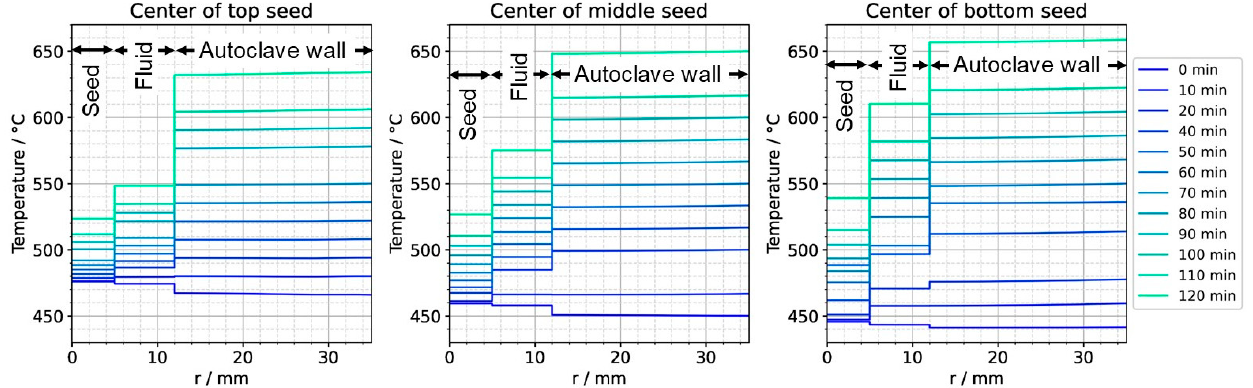
Figure 11. Temperature distribution in horizontal direction through the center of each seed (0 min: quasi-stable etch-back condition, 120 min: reaching of growth stage set temperatures).